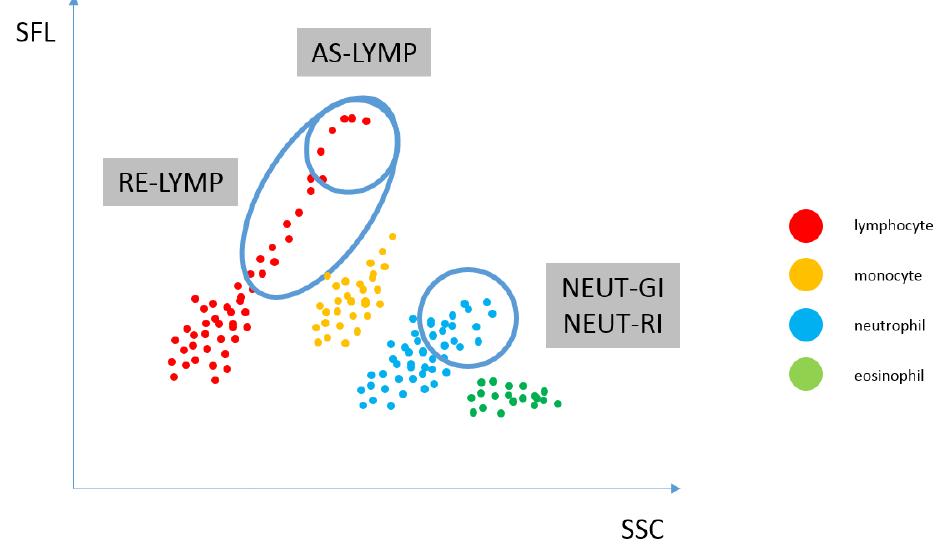
Figure 2. Reflecting the amount of reactive lymphocytes and neutrophils at different activation stages in the peripheral blood fraction. WDF scattergram showing the distribution of populations: lymphocytes (AS-LYMP population–upper marking and RE-LYMP population–lower marking), monocytes, neutrophils [the SSC signal of the neutrophil population, which is plotted on the x-axis of the scattergram, is an indicator of the granularity and internal structure of the cells (NEUT-GI) and the fluorescence intensity, which corresponds to the RNA/DNA content of the cells, is plotted on the y-axis and is an indicator of increased RNA activity (NEUT-RI)] as well as eosinophils and basophils. (AS-LYMP–Antibody-Secreting Reactive Lymphocytes, NEUT-GI–Neutrophil Granularity Intensity, NEUT-RI–Neutrophil Reactive Intensity, RE-LYMP–Reactive Lymphocytes).